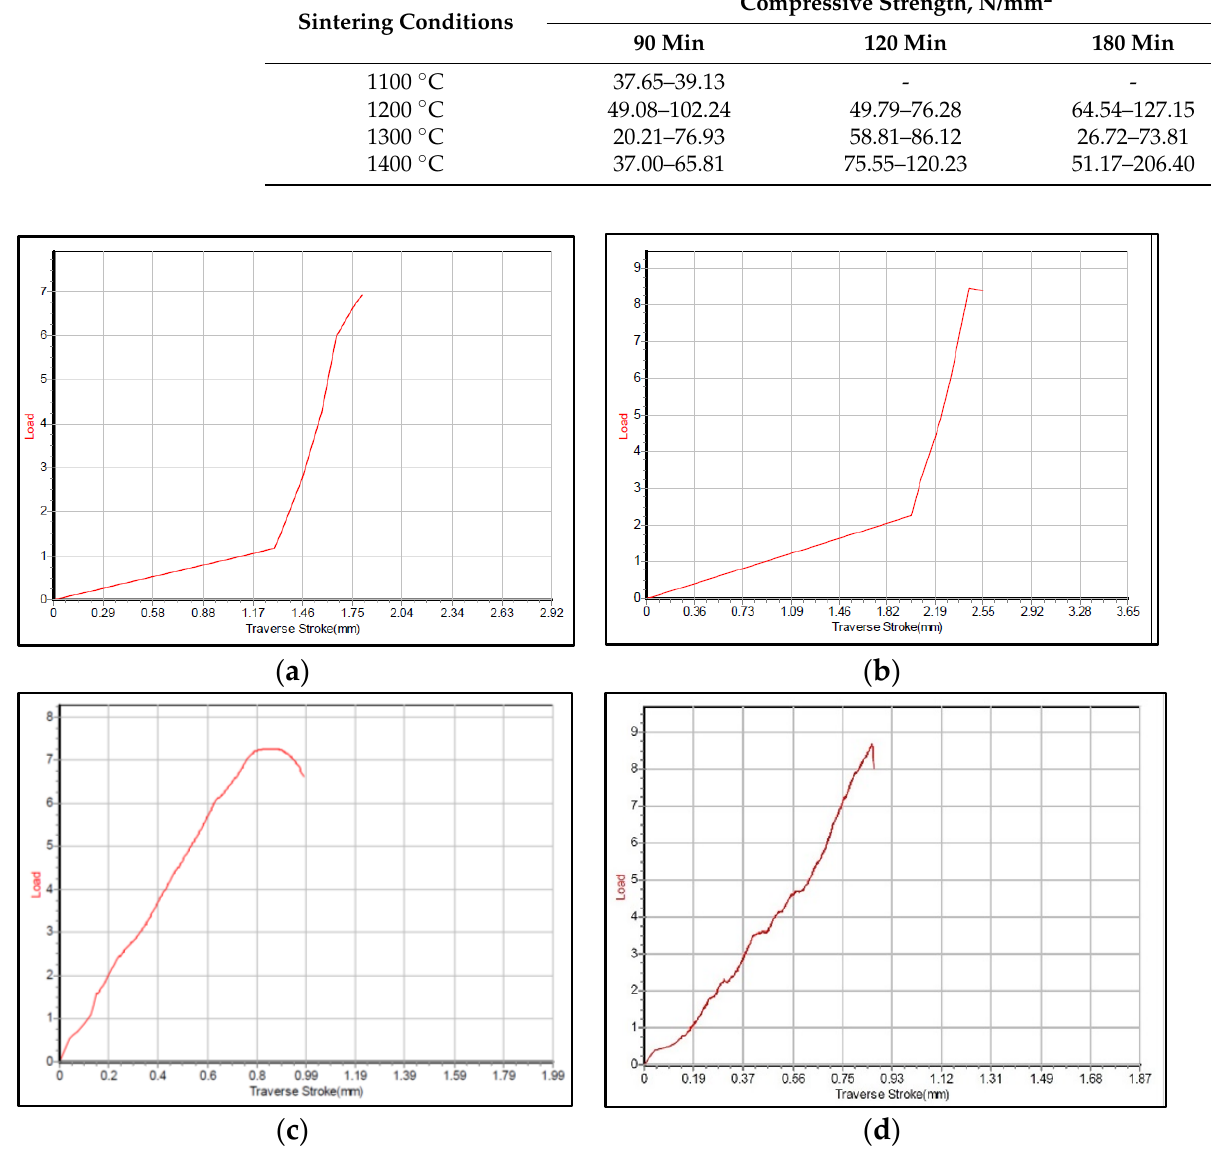
Figure 4. Examples of stress/strain curve for 90 min sintering: ( a ) 1100 °C/90 min; ( b ) 1200 °C/90 min; ( c ) 1300 °C/90 min; ( d ) 1400 °C/90 min.